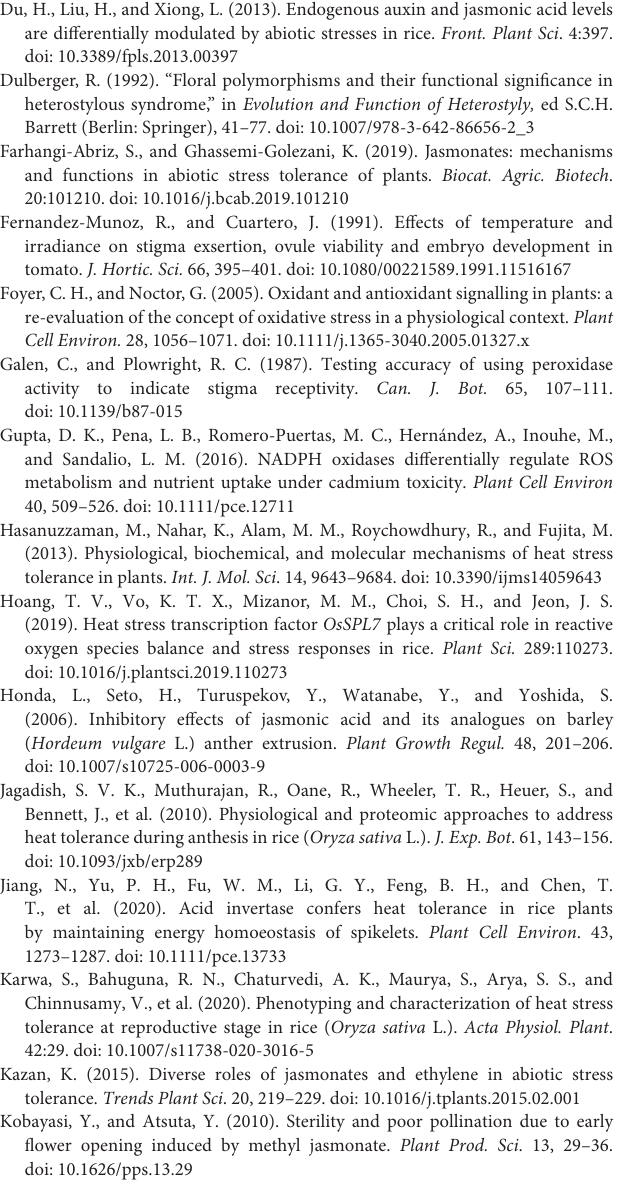
treatment; T4: 14:00 h on the first day after the temperature treatment. The bars are SD of three biological replications. Different letters above the bars represent significant differences at the P ≤ 0.05 level within the same line and the same measurement time. Supplementary Figure 2 | Effect of high-temperature stress during anthesis on the number of pollens germinated on stigma of rice. NT and HT represent normal temperature and high temperature, respectively. Luminous circles in (A–F) indicate germinated pollens. Data in G are expressed as relative values, and those of the control (NT) are taken as 100%. The bars in G are SD of six biological replications. Different letters above the bars represent significant differences at the P ≤ 0.05 level within the same line. The images of pollens germinated on single stigma were taken at 50 ×